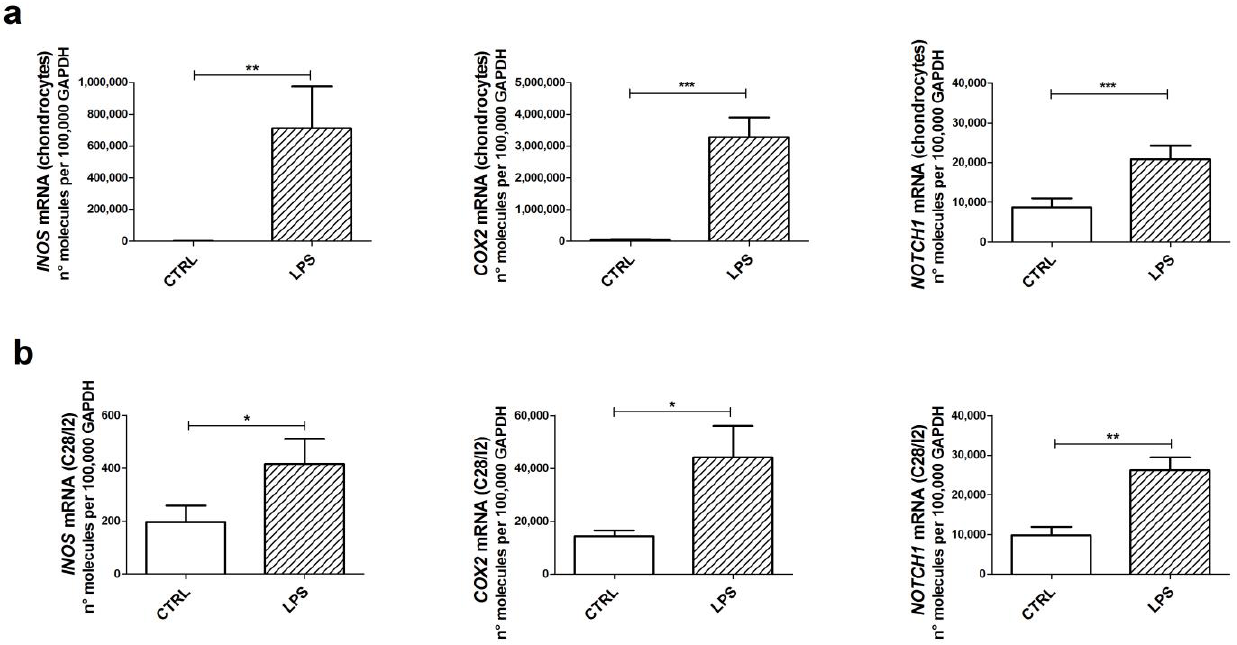
Figure 1. Effects of lipopolysaccharide (LPS) on inflammatory responses. mRNA expression of inflammation markers in primary chondrocytes ( a ) and C28/I2 chondrocytes ( b ) significantly in- creased 6 h after LPS stimulation. Data from cells treated with LPS (dashed pattern) were compared to appropriate control and obtained from the same set of samples ( n = 13 to 15 different primary chondrocyte cultures or n = 5 for C28/I2). Quantification of expression levels was calculated for each target gene and normalized using the reference housekeeping gene GAPDH. Values obtained in chondrocytes were calculated according to the formula 2 − ∆ Ct and expressed as number of molecules per 100,000 GAPDH molecules. Results are means ± SEM. Statistical analysis was performed by Student’s t test for paired samples (* p < 0.05; ** p < 0.01; and *** p <